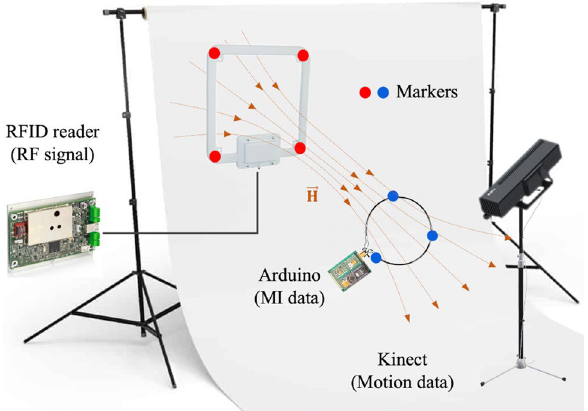
Figure 6. Measurements. Schematic representation of measurement setup, including motion capture and sensor data